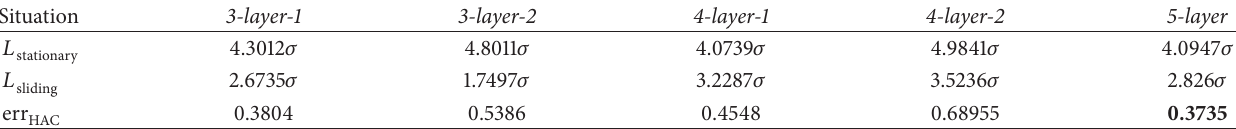
Table 4: Slip length prediction of five combinations and unified relative errors with different widths of the overlap region.